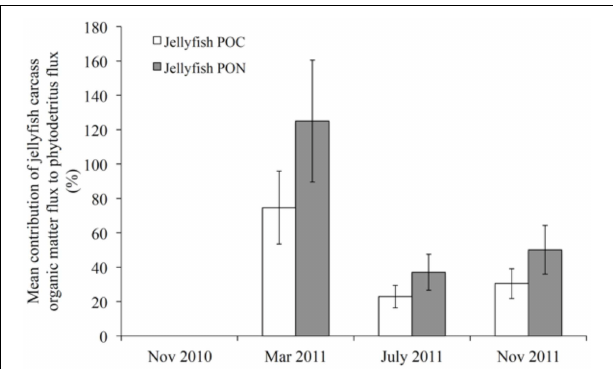
FIGURE 4 | Mean estimated contribution of jellyfish carcass C and N to phytodetritus fluxes at 447m (based on flux data in Wassmann, 1984). Error bars denote the minimum and maximum estimated